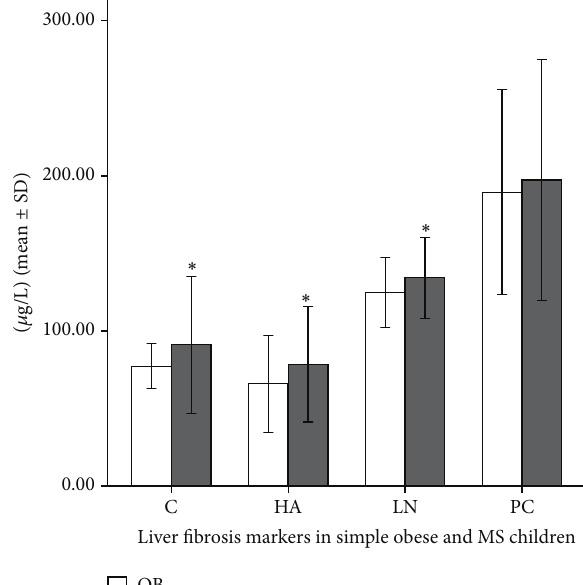
Figure 3: Hepatic fibrosis markers in simple obese and MS children. MS versus SOB, HA: 𝑃 = 0.019 ; CIV: 𝑃 = 0.021 ; LN: 𝑃 = 0.013 ; PCIII: 𝑃 = 0.48 . ∗ refers to 𝑃 < 0.05 and the difference between two groups was significant. Error bars: ± 1 SD.